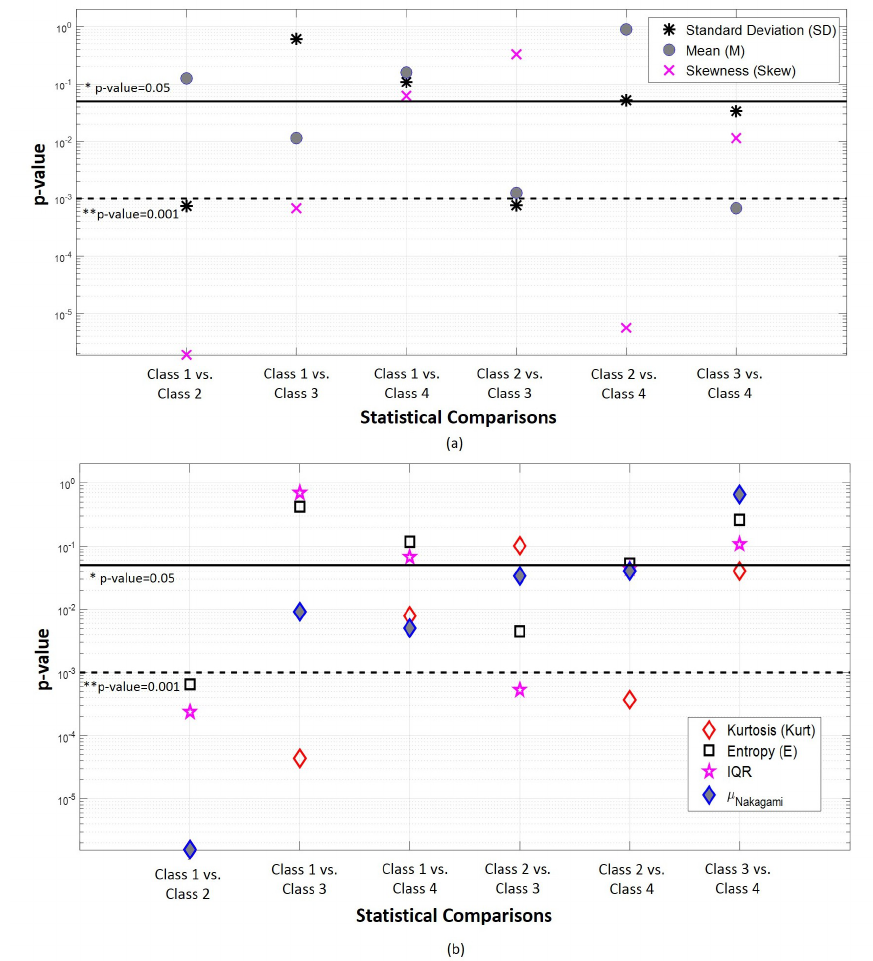
Figure A1. p -values obtained for the six post hoc parwise statistical comparisons (using the Mann Whitney test) that were performed after applying the Kruskal-Wallis test for 4 classes comparisons (time-domain features). ( a ) Statistical results obtained for Standard Deviation (SD), Mean (M) and Skewness (Skew). ( b ) p -values obtained for the comparisons relatively to Kurtosis (Kurt), Entropy (E), Interquartile Range (IQR) and µ Nakagami . Vertical axis is in logarithmic